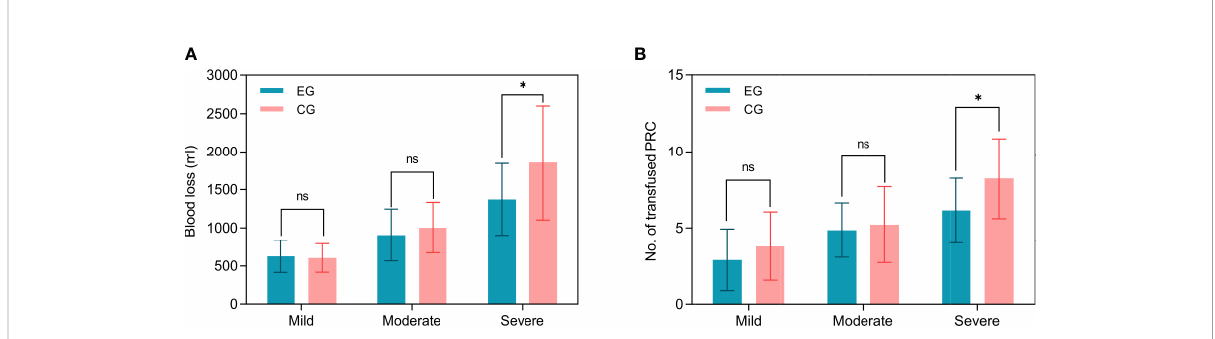
FIGURE 3 Subgroup analyses of blood loss and number of PRC transfusion among MESCC patients strati fi ed by the degree of hypervascularity. (A) Intra- operative blood loss; (B) Number of PRC transfusion. EG indicates the embolization group; CG indicating the control group. “ ns ” indicates no signi fi cance, and “ * ” indicates